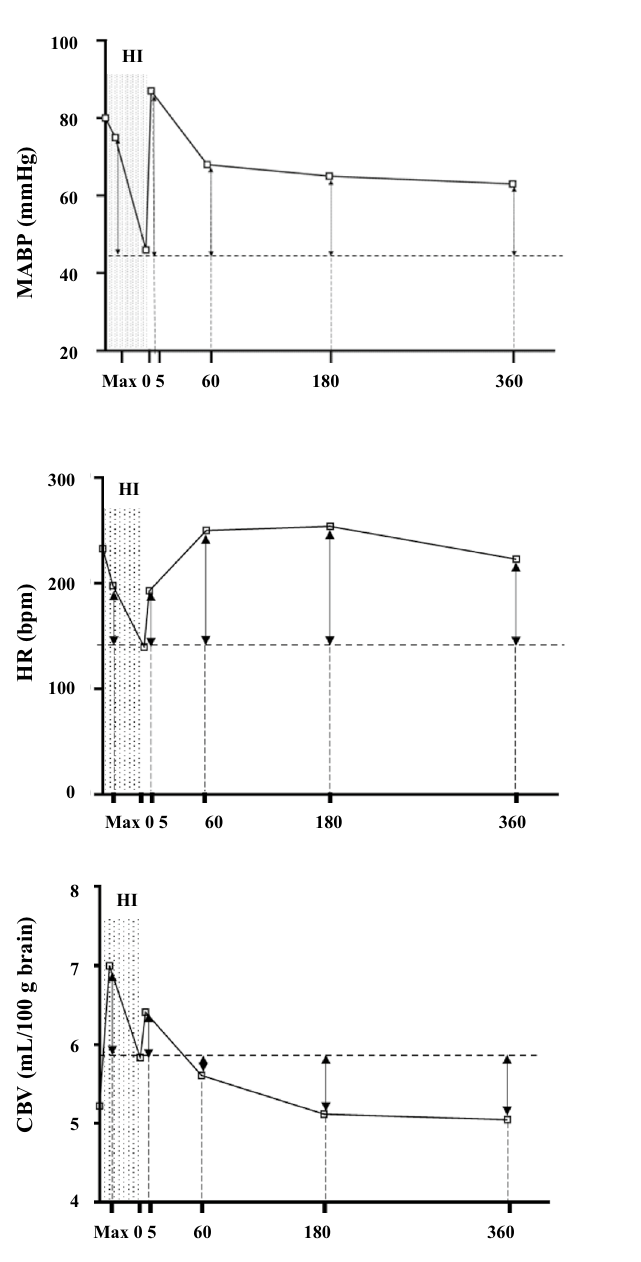
Figure 5. Graphical representation of the increments in CBV, HR, and MABP during HI insult and at 5, 60, 180, and 360 min after insult. Increments in CBV were calculated as the differences between the CBV value at the end of insult and the maximum CBV value during insult and the CBV at 5 min, 60 min, 180 min, and 360 min after insult. Increments in HR were calculated as the differences between the HR value at the end of insult and the HR value at the maximum CBV during insult and the HR at 5 min, 60 min, 180 min, and 360 min after insult. Increments in MABP were calculated as the differences between the MABP value at the end of insult and the MABP value at the maximum CBV during insult and the MABP at 5 min, 60 min, 180 min, and 360 min after